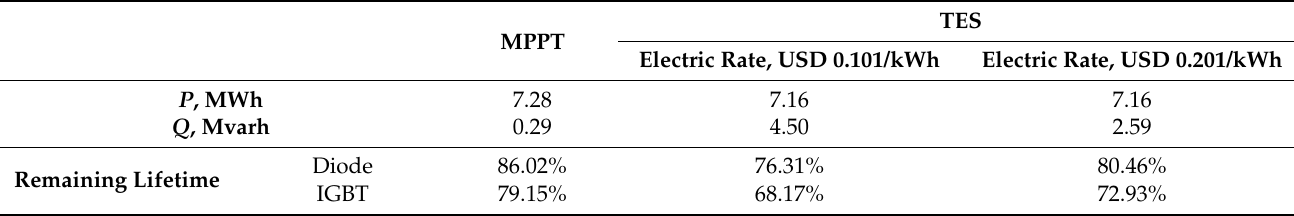
Table 18. Simulation result from the TES test